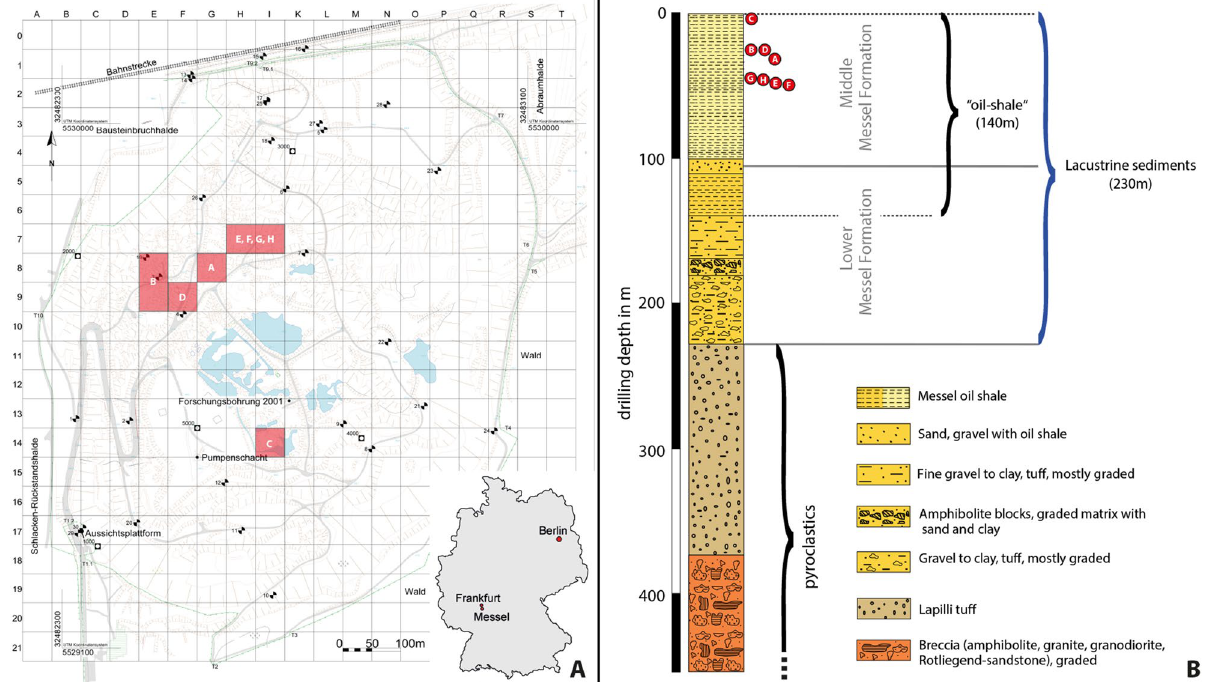
Figure 1. ( A ) Map of the Grube Messel site (from 12 ) with the location of each shrimp fossil (A–H) indicated. (A) SF-MeI 5933 (holotype); (B) SF-MeI 13611; (C) SF-MeI 14640; (D) SF-MeI 16018; (E) HLMD-Me-10684; (F) HLMD-Me-10646; (G) HLMD-Me-13919 and (H) HLMD-Me-13920. ( B ) Section of the Grube Messel core (modified from 13 ). Red circles indicate the corresponding layers where the fossil shrimps were found. Depth: for (C) ca. 2.96 m to 2.16 m; for (B) and (D): ca. 24.86 m to 23.86 m; for (A): ca. 27.46 m to 27.06 m; for (G): ca. 46.49 m to 45.97 m; for (H): ca. 46.03 m; for (E): ca. 46.26 m; for (F): ca. 47.2